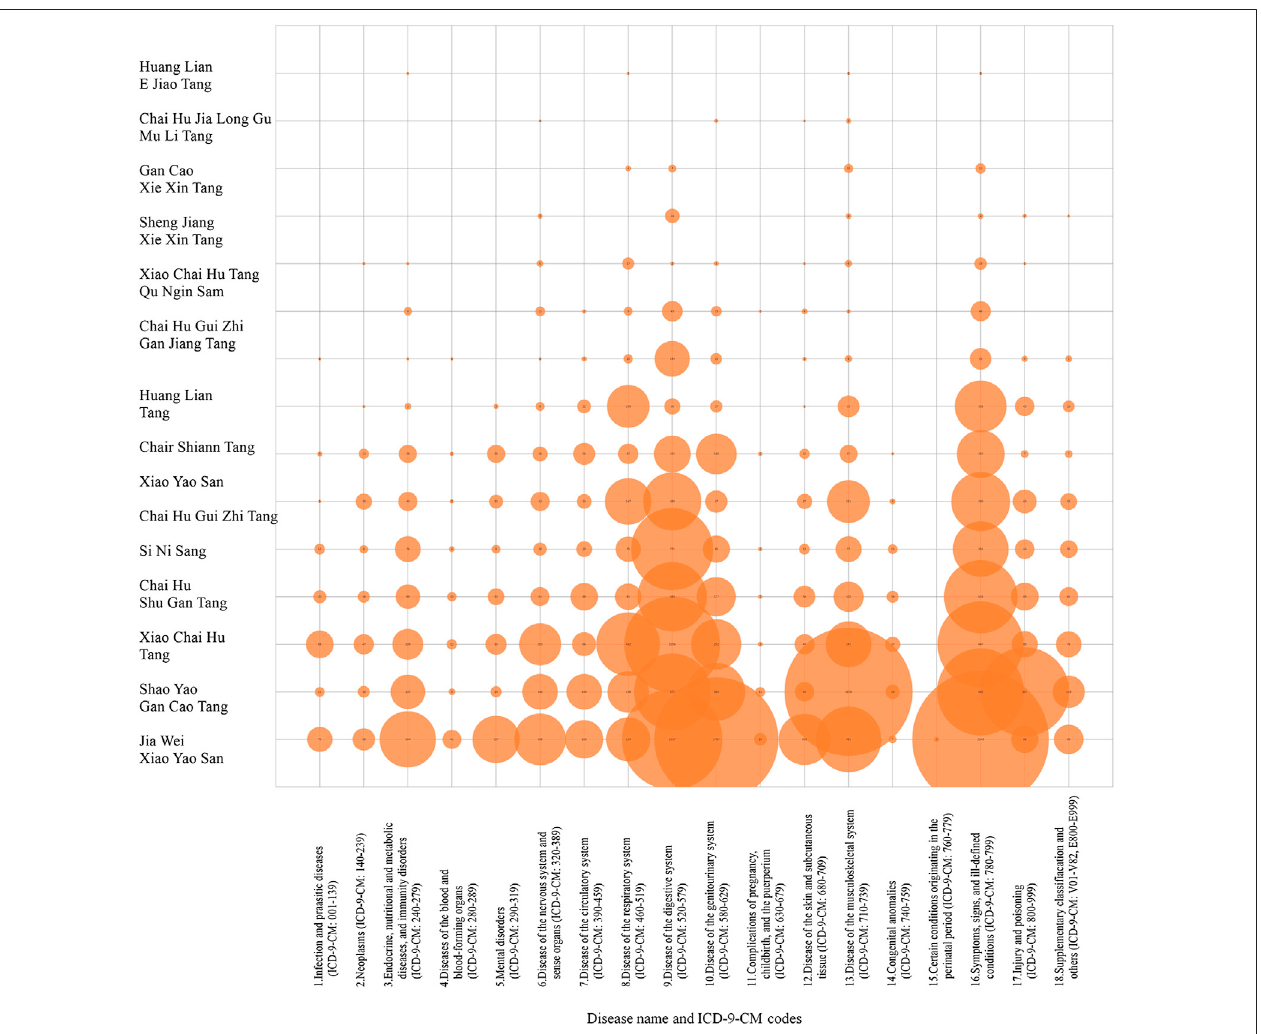
FIGURE 1 | Prescription frequency of constituent herbs of harmonizing formulas categorized by systematic disease and related health problems in patients with chronic kidney disease.